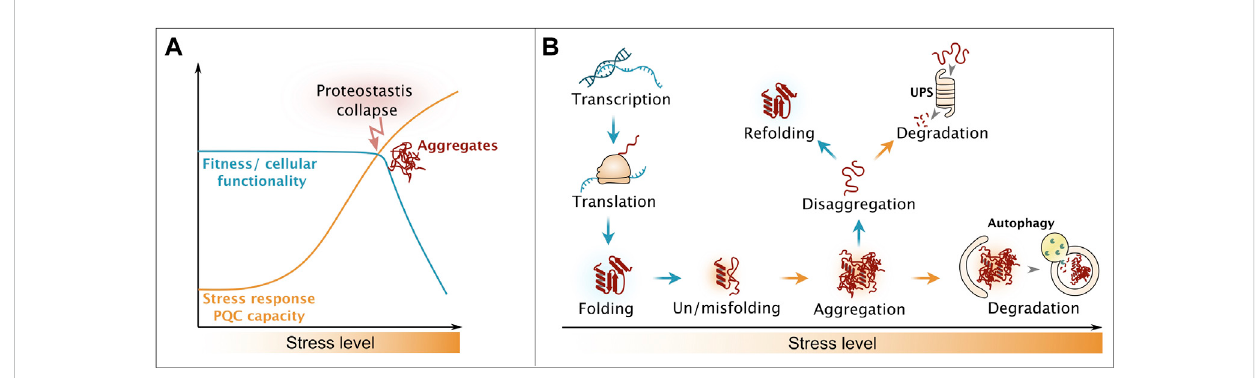
FIGURE 1 In fl uence of proteostatic stress on cellular fi tness. (A) Upon increase of proteotoxic stress, cells activate stress response regimes, ensuring on keeping cellular processes functional. Overburden results in the collapse of the proteostasis system and occurrence of aggregates, leading to